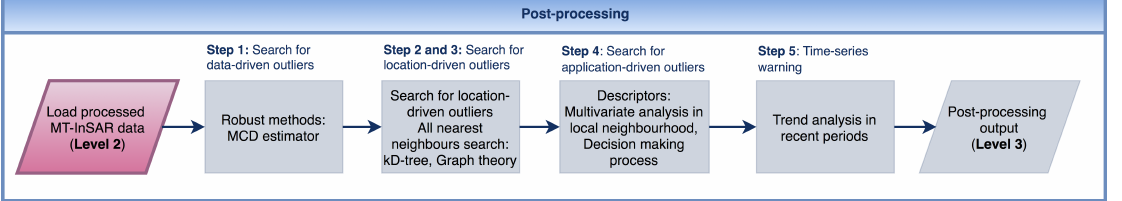
Figure 4. Flowchart of the post-processing methodology. Interested readers could refer to [36] for the comparison with previous